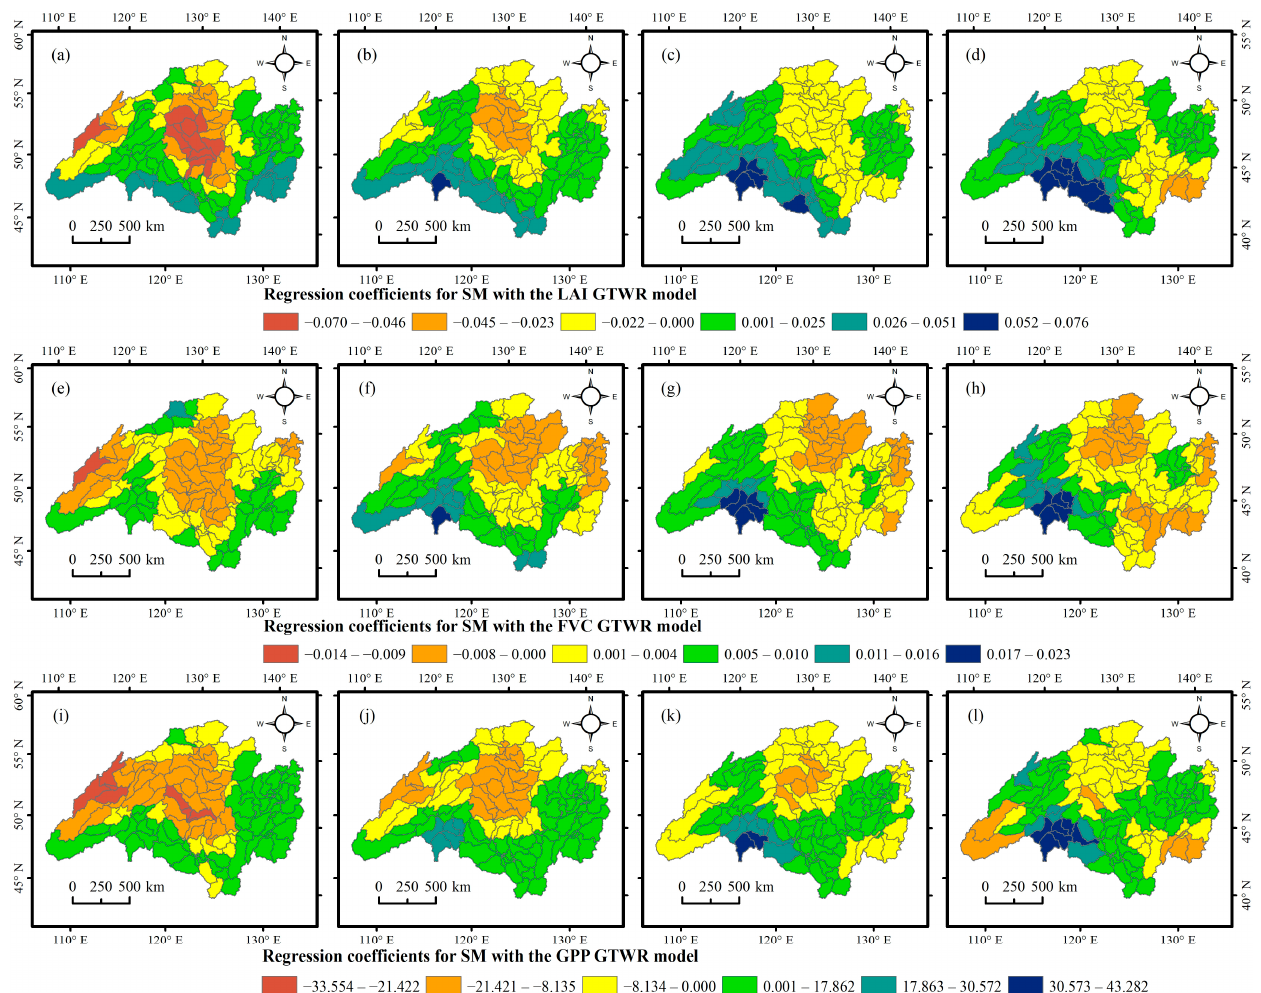
Figure 10. The spatial distribution of the regression coefficients for SM with the LAI (( a – d ) shows the coefficients for Periods 1–4, respectively), FVC (( e – h ) exhibits the coefficients for Periods 1–4, respectively), and GPP (( i – l ) presents the coefficients for Periods 1–4, respectively) GTWR models for the four studied periods.